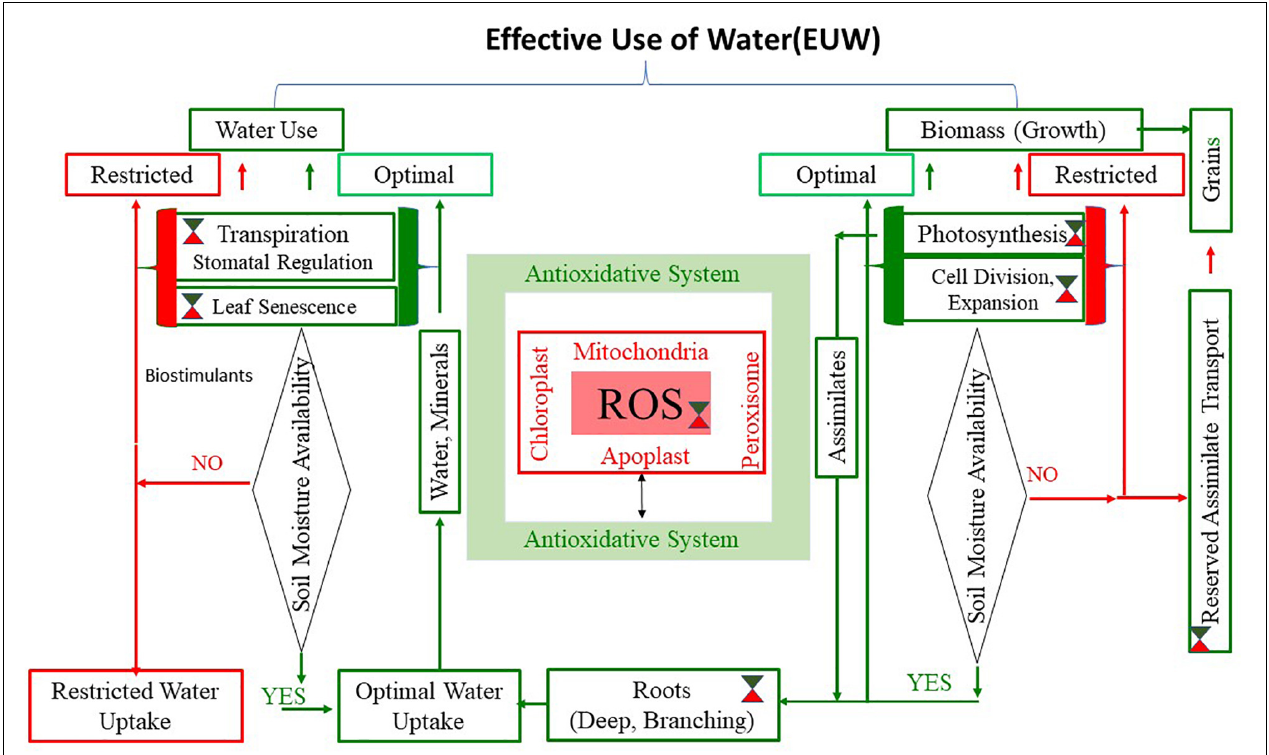
FIGURE 1 | Water use by plants and biomass production are the two major components of Effective Use of Water (EUW). The figure is based on the fact that enhanced EUW is possible if water use by plants drives biomass production rather than biomass produced at a given time drives water use. The implications of reactive oxygen species and anti-oxidative system (ROS-AOS) that operates at mitochondria, chloroplast, peroxisome, and apoplast (shown at the center of the figure) are evident from scientific leads. The green/red symbol ( indicates opportunities to use ROS-AOS as feasible switches to put on or off the processes and functions required to achieve high EUW during optimal (green lines) and restricted (red lines) phases of soil moisture regime during the drought cycle. As shown in the Table 1 , association of ROS-AOS is evident in the stomatal mechanism, water uptake and transport, and leaf senescence, which contribute to water use regulation while photosynthesis, cell division, and expansion assimilate transport, which are all linked with biomass production. Alternatively, exogenous bioactive compounds may be evaluated to get desired effect on each of the components to achieve maximum EUW based on the soil moisture regime, plant growth stage, and nature of